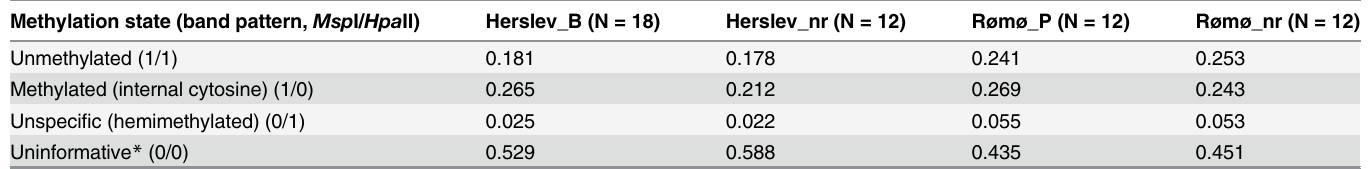
Table 1. Frequencies (%) of the different states of methylation in the samples.